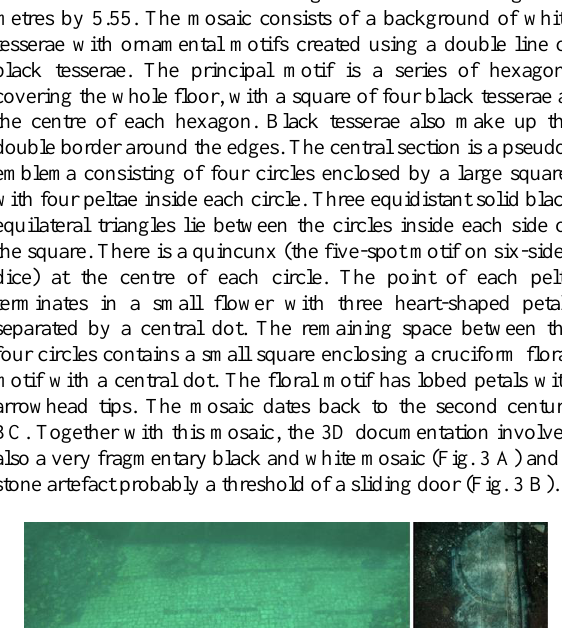
Fig. 1. Baiae. A particular of the opus sectile floor after restoration (ISCR Archive).